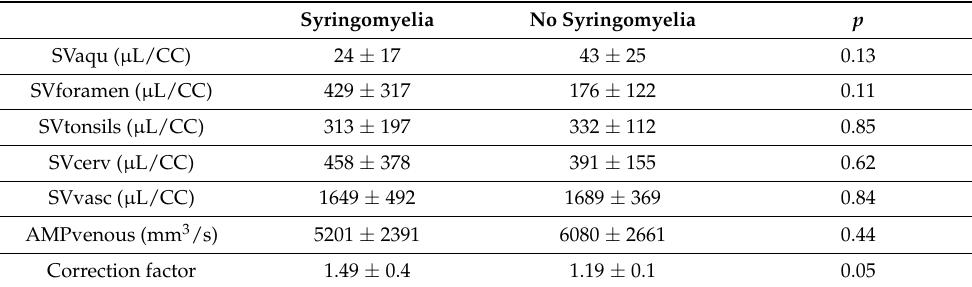
Table 3. Preoperative hemodynamic and hydrodynamic parameters in syrinx and non-syrinx patients. CC: cardiac cycle, SVaqu: stroke volume of CSF in Sylvius aqueduct, SVforamen: stroke volume of CSF at the foramen magnum level, SVtonsils: stroke volume of tonsils, SVcerv: stroke volume of CSF at cervical level, SVvasc: stroke volume of arteriovenous system, AMPvenous: amplitude of venous flow curve, correction factor: factor of correction for venous flow curve—when it is close to 1, venous drainage is mainly due to the jugular veins, whereas, when it is >1, an accessory pathway is involved, SVsyrinx: stroke volume into the syringomyelia.